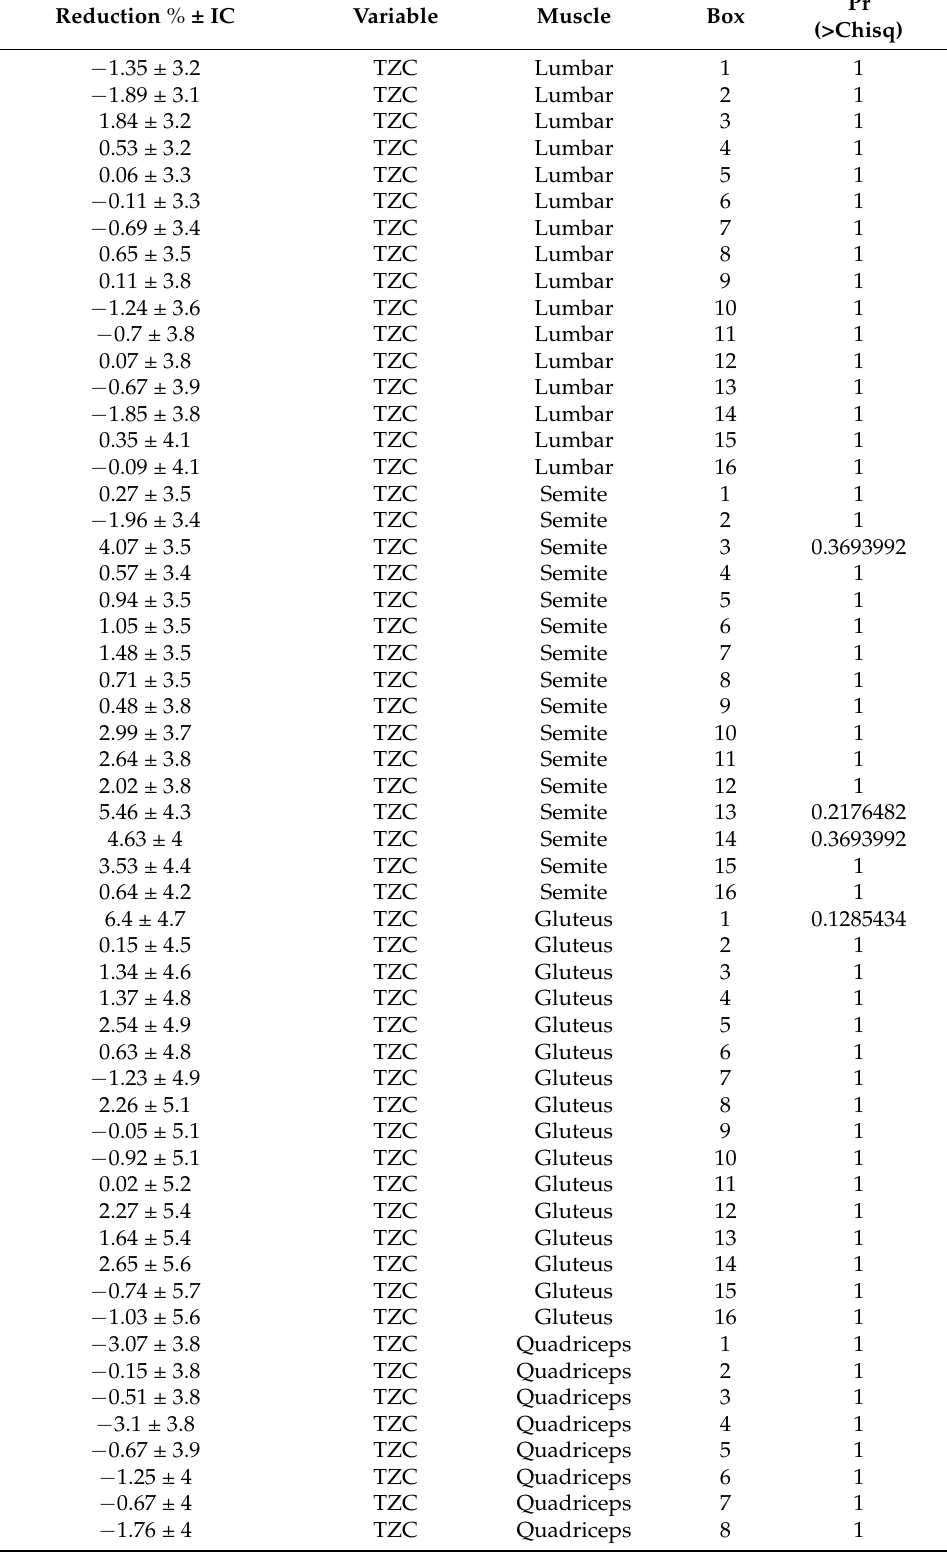
Table A3. The first column includes the percentile of reduction with the confidence interval. The second column shows the variable, in this case, the TZC; the third column, the muscle; and the fourth column, the number of box. Last value contains the p -value of the